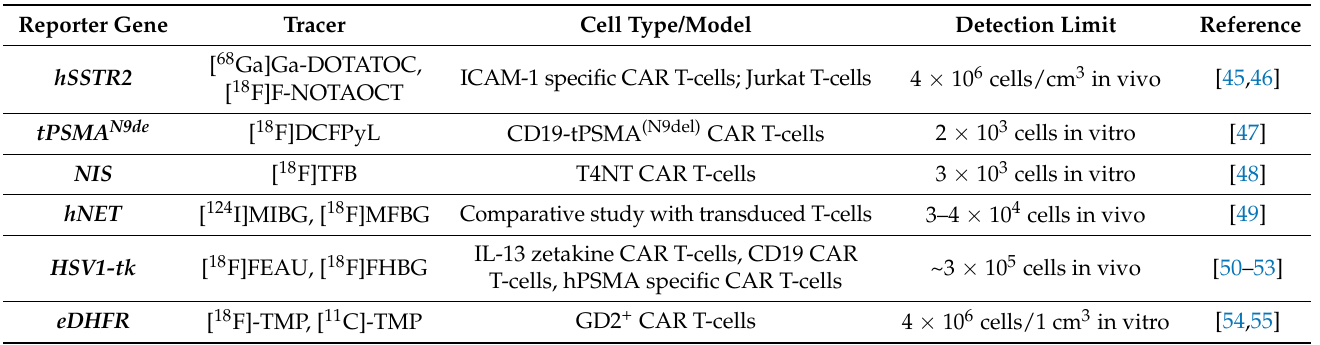
Figure 2. Overview of gene reporters for the tracking of therapeutic cells using different PET tracers. The transfection of cells with a vector plasmid leading to the expression of reporter genes in cells can be detected using PET imaging with radiotracers targeting specific 1 (cid:13) receptors, 2 (cid:13) cell surface enzymes, 3 (cid:13) protein transporters, and 4 (cid:13) intracellular enzymes. The respective PET tracer for each reporter gene discussed in the text is indicated in brackets. The figure was partly created with BioRender.com (accessed on 7 June 2021). Table 2. Summary of reporter genes used for the imaging of CAR T-cells in